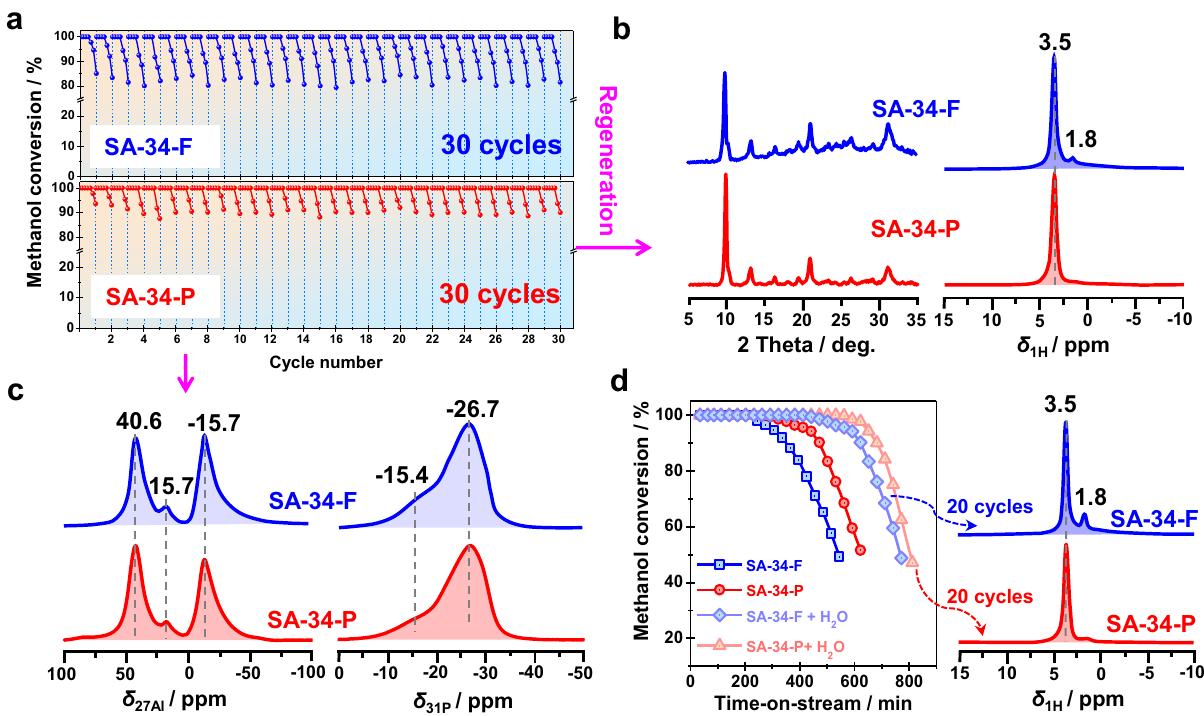
Fig. 6 Stability of SAPO-34 zeolite after continuous repeated regenerations. a Recycling studies of SAPO-34 catalysts applied in the MTO conversion at 673 K with and without pre-coking. b XRD patterns and 1 H MAS NMR spectra of the regenerated SAPO-34 catalysts after 30 cycles in the MTO conversion. c 27 Al and 31 P MAS NMR spectra of the regenerated SAPO-34 catalysts after 30 cycles in the MTO conversion and after hydration at room temperature for 24 h. d Methanol conversion before and after water co-feeding (20 Vol%) over SA-34-F and SA-34-P catalysts at 673 K (left). 1 H MAS NMR spectra of the regenerated SAPO-34 catalysts after 20 cycles in the MTO conversion with water co-feeding